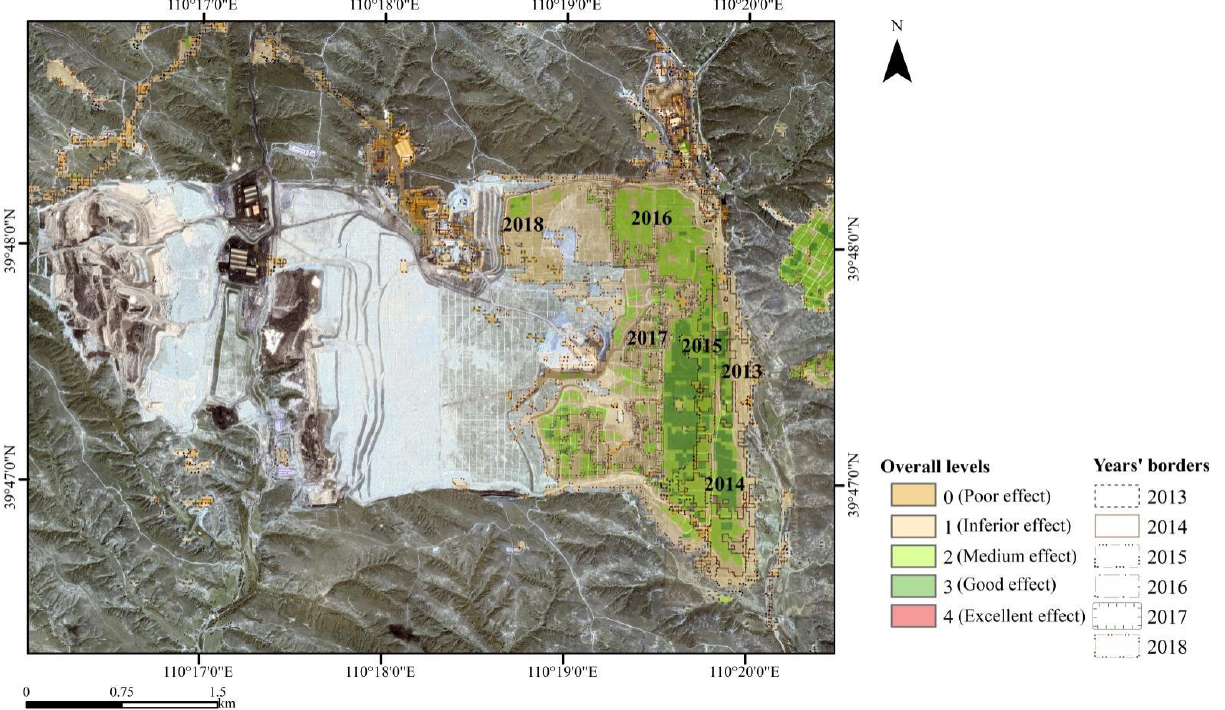
Figure 13. Overall restoration vegetation effects from 2013 to 2018 (from 0.23 m, true color, Google Earth image in August 2019).